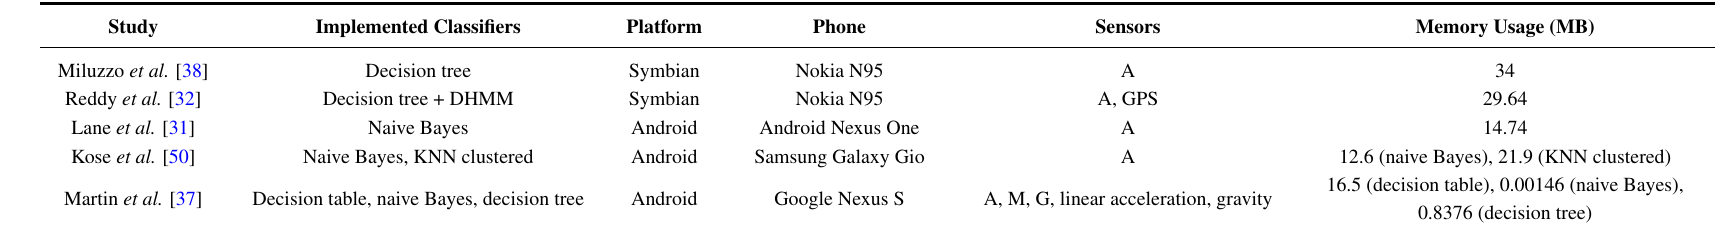
Table 9. Studies with memory usage